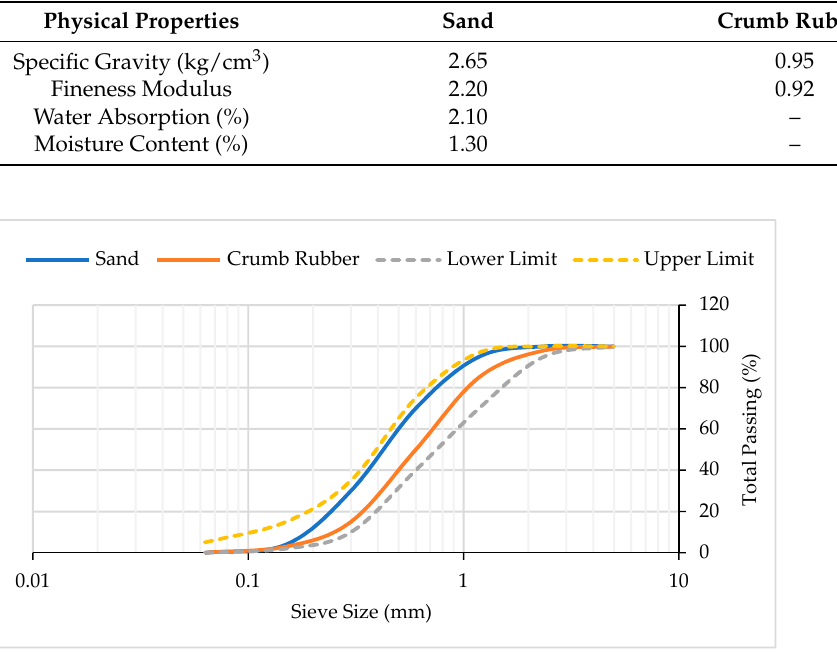
Table 3. Physical properties of fine aggregates.